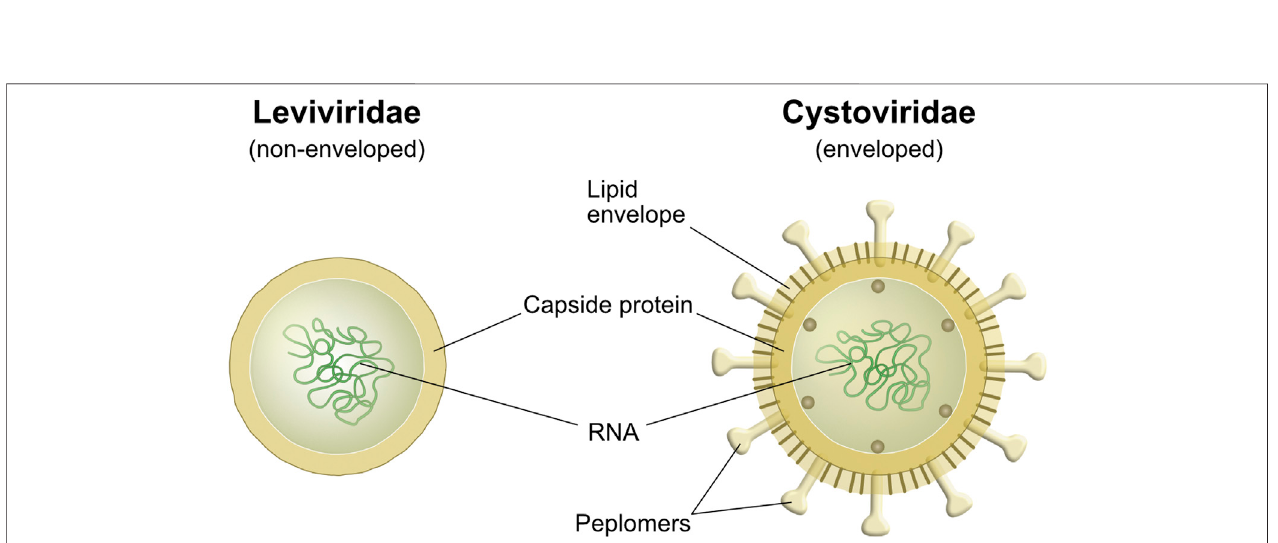
FIGURE 2 | Schematic drawing of the cross section of viral particles from a) Leviviridae and b) Cystoviridae (King et al., 2011). Leviviridae represents a non- enveloped phage and Cystoviridae an enveloped phage with spikes/peplomers protruding through the lipid envelope.